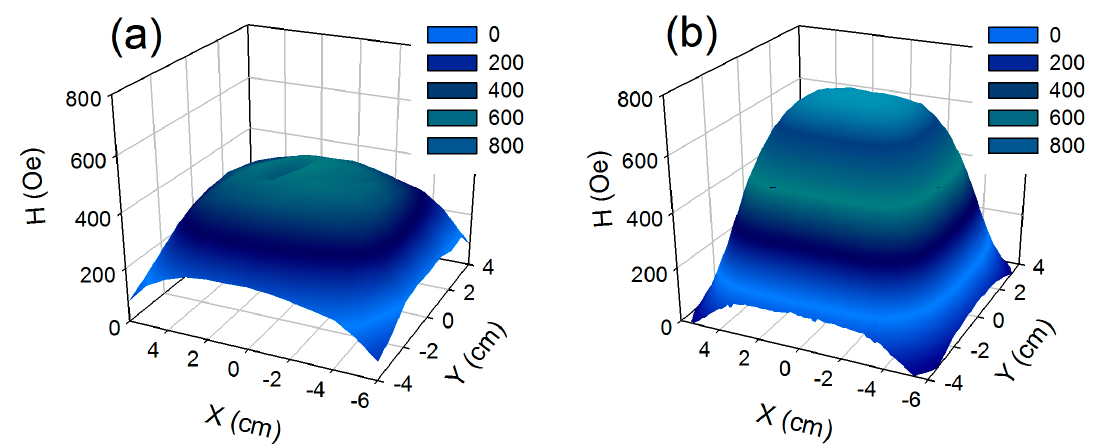
Figure 3. Magnetic field distribution created by the magnetic system in XY plane at Z = 2 cm: ( a ) results of measurements; ( b ) results of finite-element computer simulation.